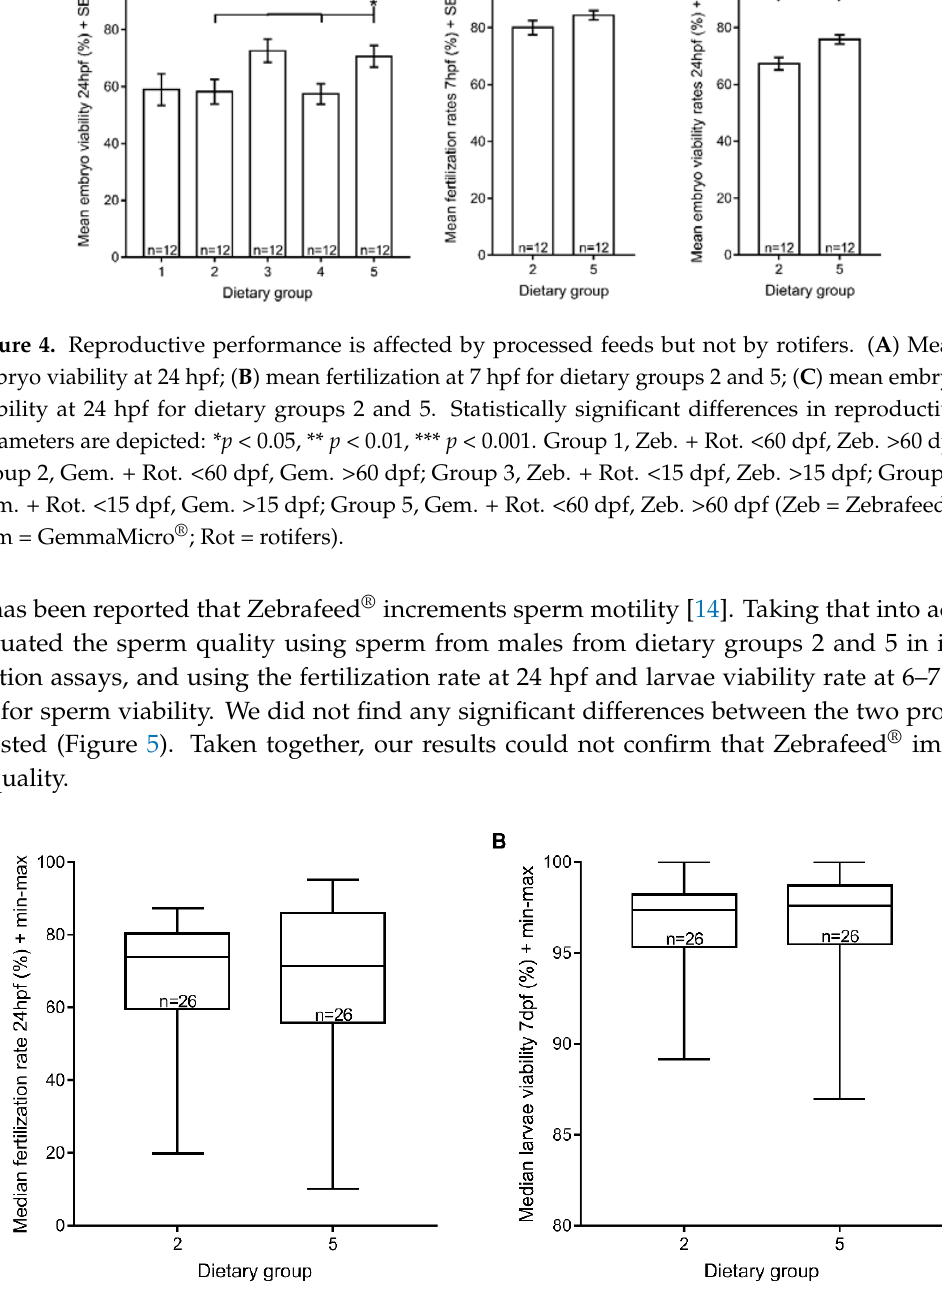
Figure 5. Sperm viability was not affected by processed feeds. ( A ) Median in vitro fertilization rate using sperm from males under GemmaMicro ® (dietary group 2) or Zebrafeed ® (dietary group 5) at 24 hpf; ( B ) corresponding larvae viability rate (6–7 dpf). There were no statistically significant differences, for either parameters. Group 1, Gem. + Rot. <60 dpf, Gem. >60 dpf; Group 5, Gem. + Rot. <60 dpf, Zeb. >60 dpf (Zeb = Zebrafeed ® ; Gem = GemmaMicro ® ; Rot = rotifers).